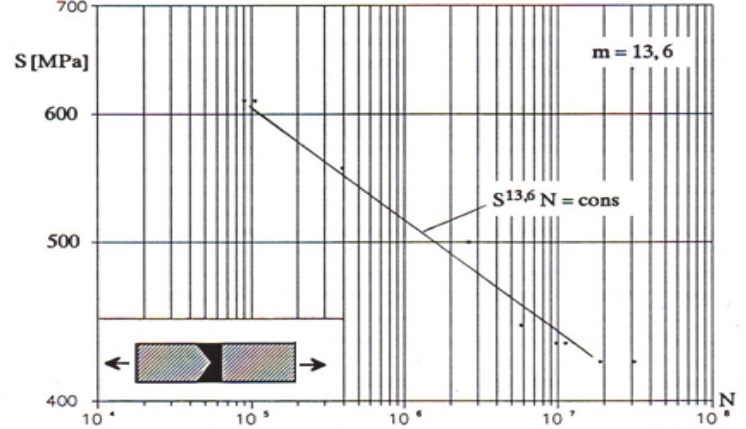
Figure 2: S-N Relationship for K-grooved butt weld.